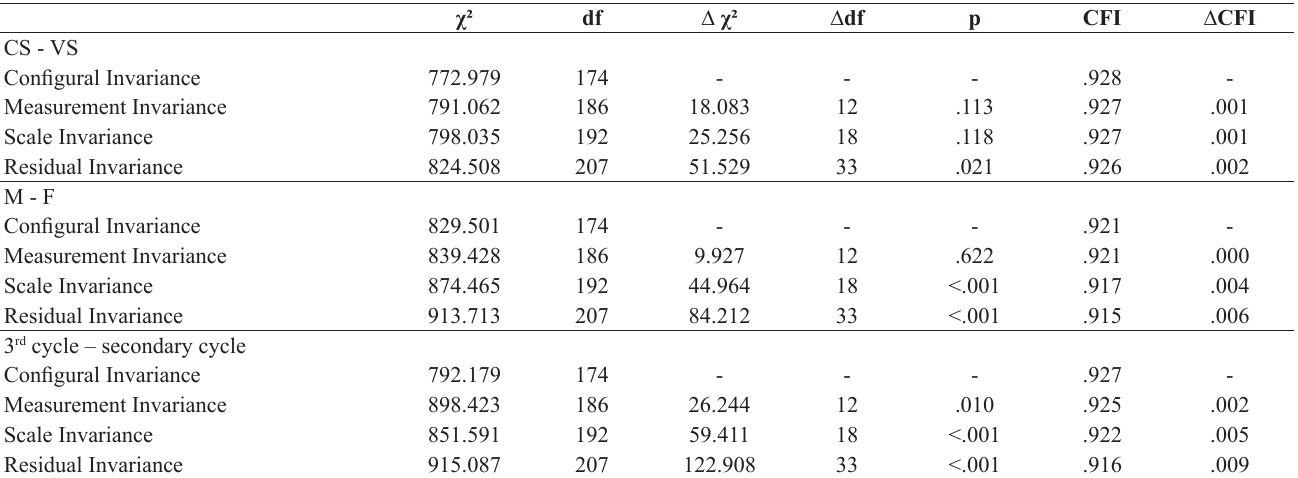
Table 4a. Fit indices for the invariance of the measurement model of the PESS in the Portuguese sample across samples, gender and cycles in the three factor